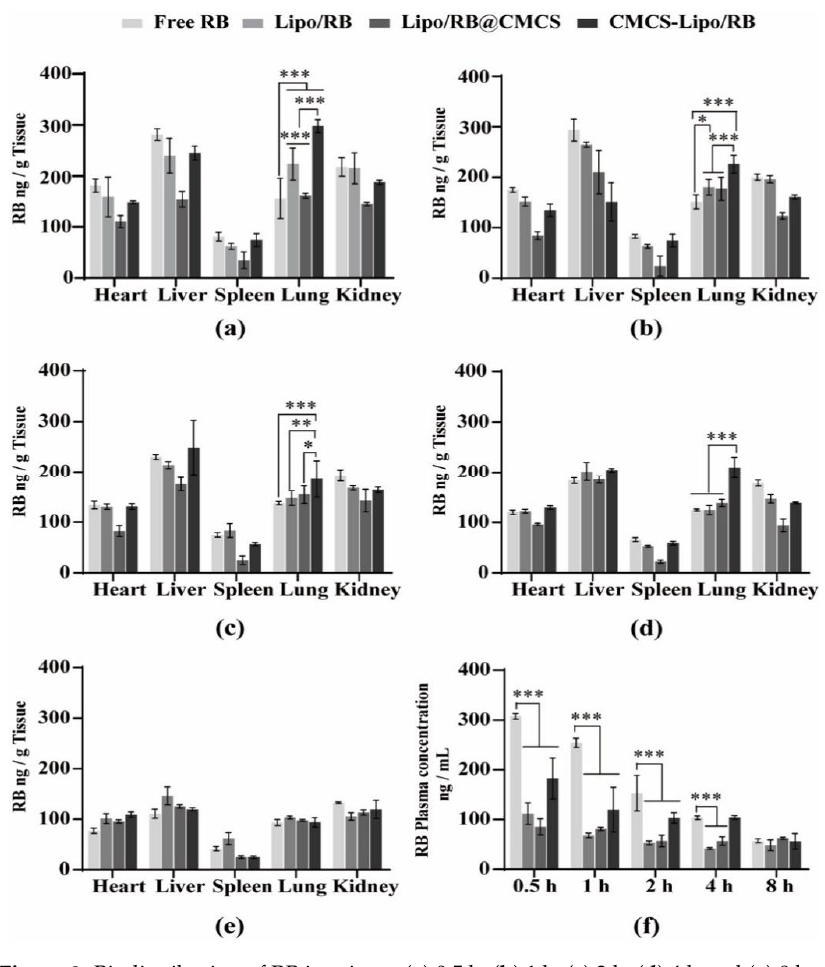
Figure 2. Biodistribution of RB in mice at ( a ) 0.5 h, ( b ) 1 h, ( c ) 2 h, ( d ) 4 h and ( e ) 8 h after quantitative pulmonary administration of RB preparations and ( f ) the plasma concentration of RB. All the data were expressed as mean ± SD ( n = 6). * p < 0.05, ** p < 0.01, *** p < 0.001.